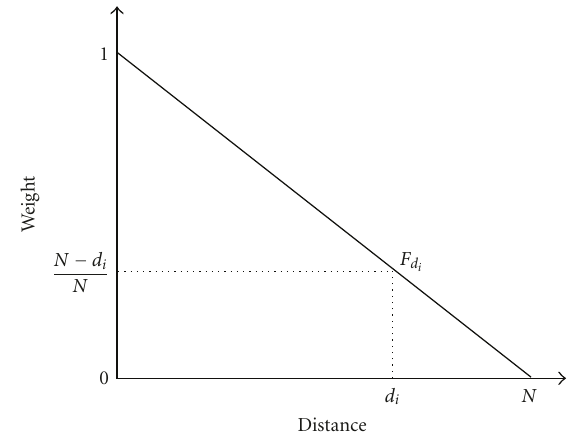
Figure 7: Weighted rate